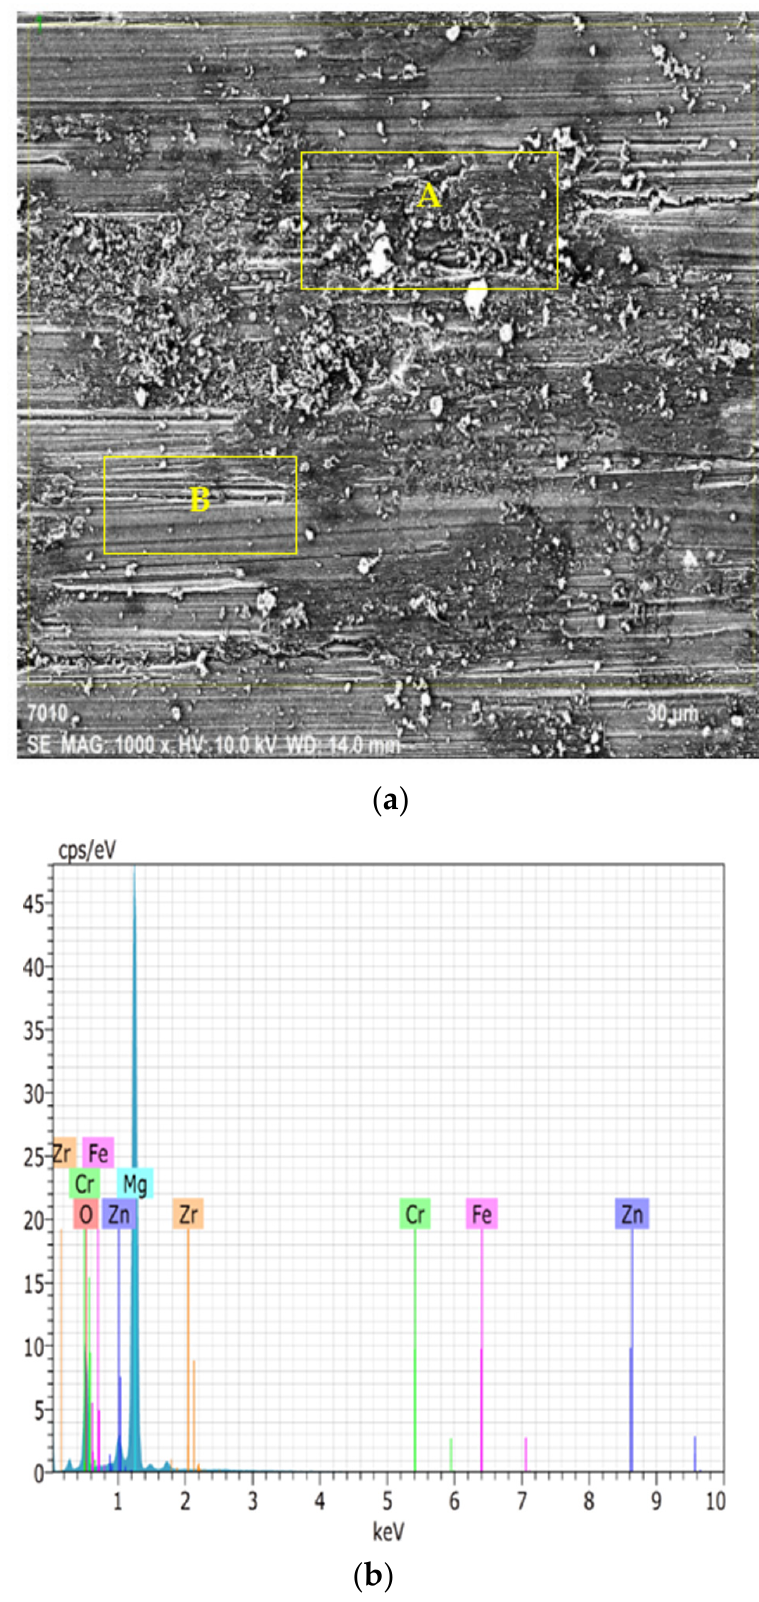
Figure 15. Worn surface: ( a ) SEM image at 1k × ; ( b ) the elemental spectrum response graph of the unreinforced ZK60. Table 5. General EDX analyses of the image shown in Figure 15a.